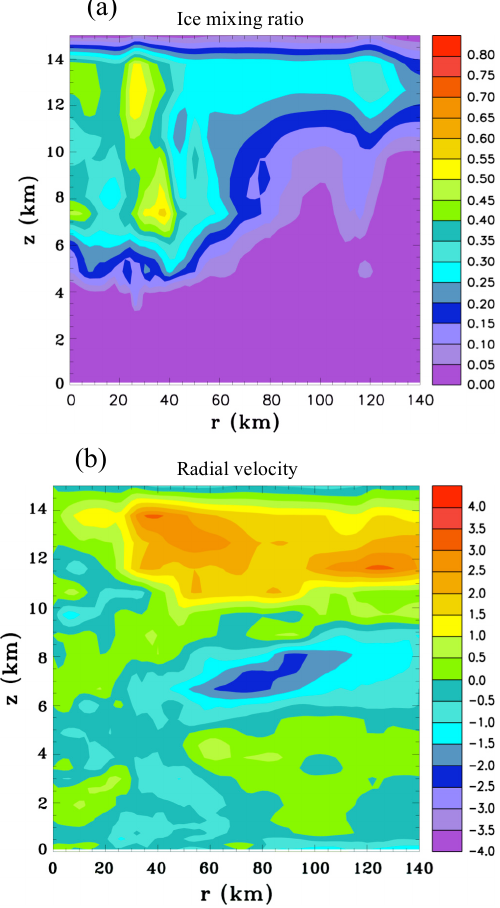
Fig. 12. Azimuthally averaged fields of (a) Mixing ratio of ice (g kg − 1 ), and (b) radial component of wind velocity (m s − 1 ), at t = 75h, for Experiment Figure. 12. Azimuthally averaged fields of (a) Mixing ratio of ice (g kg -1 ), and (b) radial component of wind velocity (m s -1 ), at t=75 h, for Experiment 2.